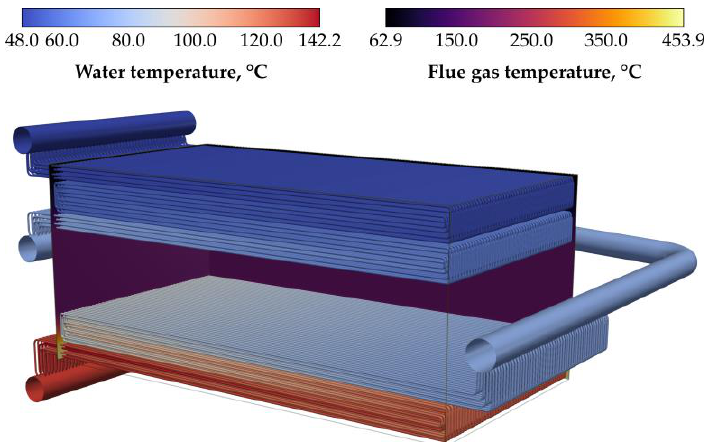
Figure 14. Visualization generated in Kitware ParaView of the bundles and the surrounding portion of the flue gas duct (front faces are culled). These were colored by the tube-side (water) and the shell-side (flue gas) temperatures obtained using the FEA-based model.